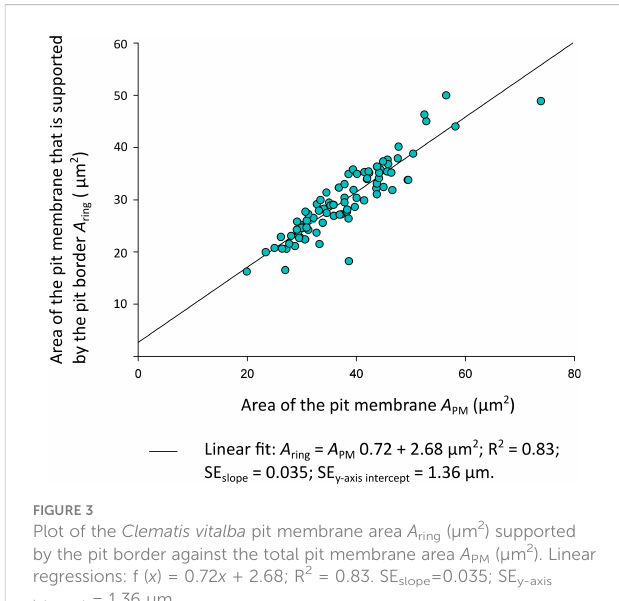
FIGURE 3 Plot of the Clematis vitalba pit membrane area A ring (µm 2 ) supported by the pit border against the total pit membrane area A PM (µm 2 ). Linear regressions: f ( x ) = 0.72 x + 2.68; R 2 = 0.83. SE slope =0.035; SE y-axis intercept = 1.36 µm.